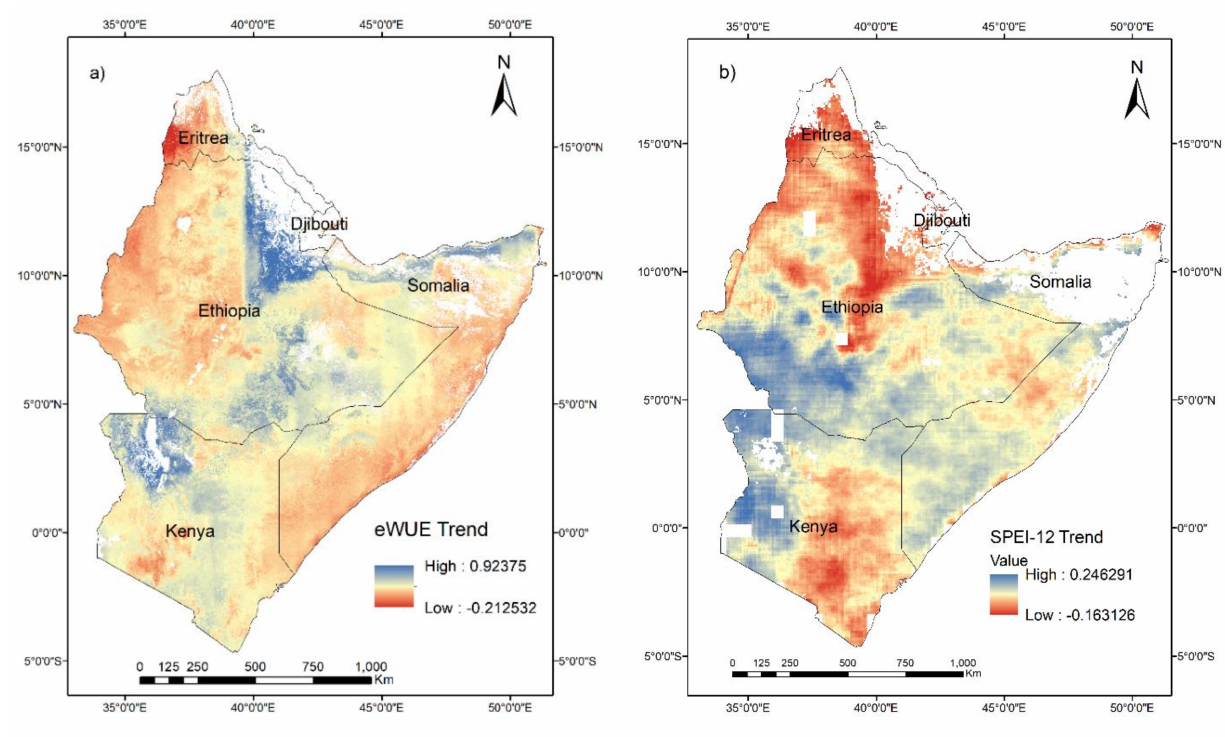
Figure 8. ( a ) Ecosystem water use efficiency annual trend; ( b ) drought trend using SPEI-12 in the Horn of Africa during 2000–2019.